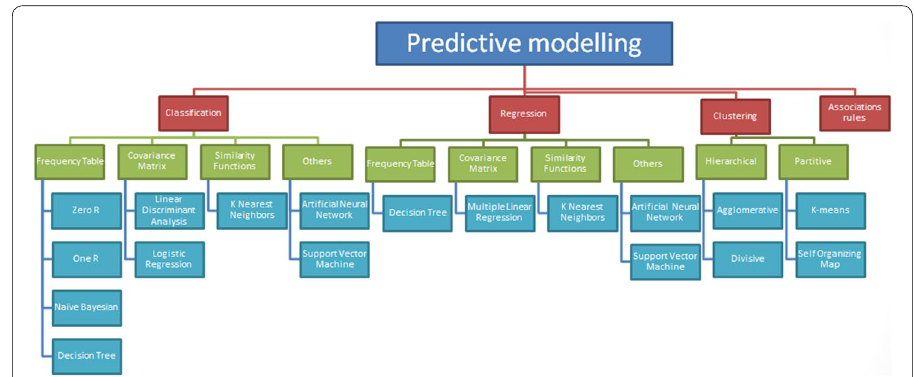
Fig. 2 Predictive modelling